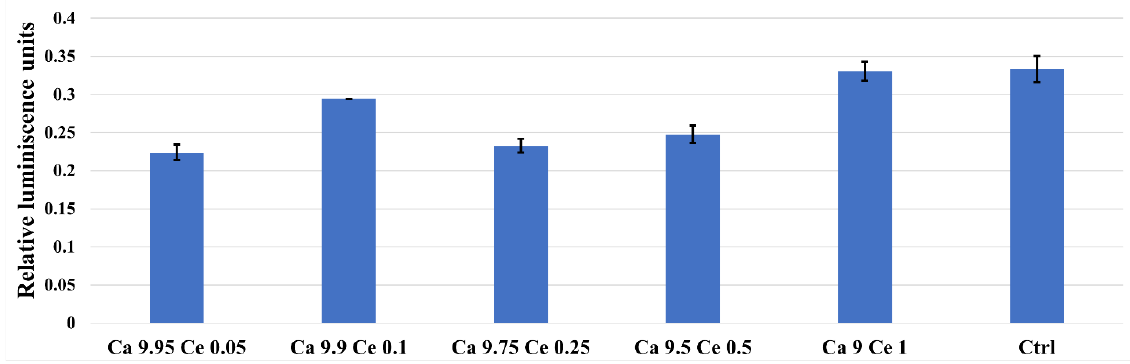
Figure 10. GSH assay showing the oxidative stress of AFSC in the presence of the cerium-doped HAp nanomaterials and control (cell only).